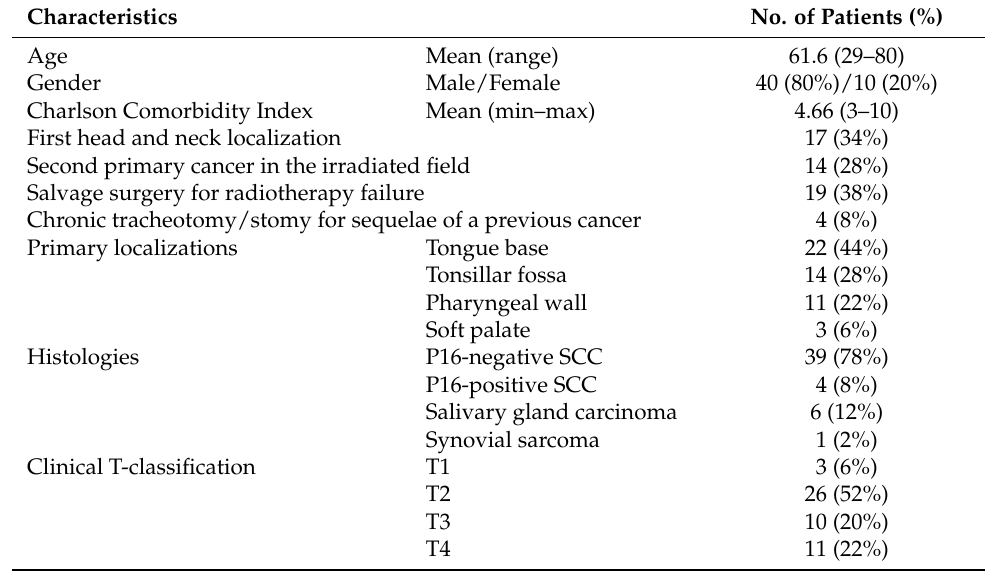
Table 1. Epidemiological and clinical characteristics of the first 50 patients who underwent transoral robotic surgery and a free flap reconstruction at our